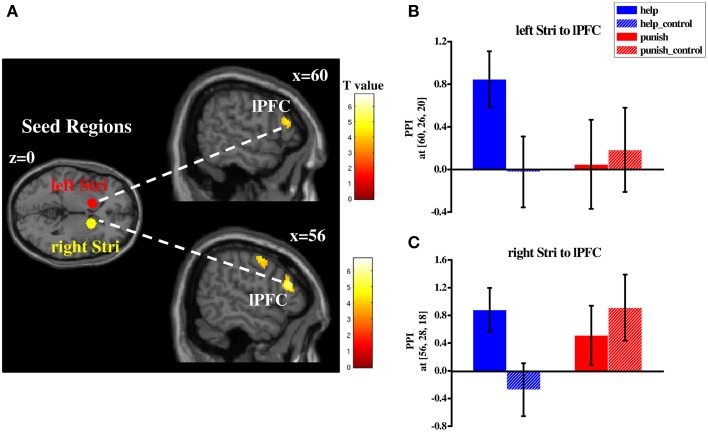
Regions showing increased functional connectivity with bilateral striatum during third-party help decisions (compared with control conditions; (A) and plots of parameter estimates of PPI in the local peak voxel of right lPFC with left (B)/right (C) striatum in four conditions (i.e., help, help_control, punish, punish_control). Abbreviations: PPI, psycho-physiological interaction; lPFC, lateral prefrontal cortex; Stri, striatum; Error bars: SEM.